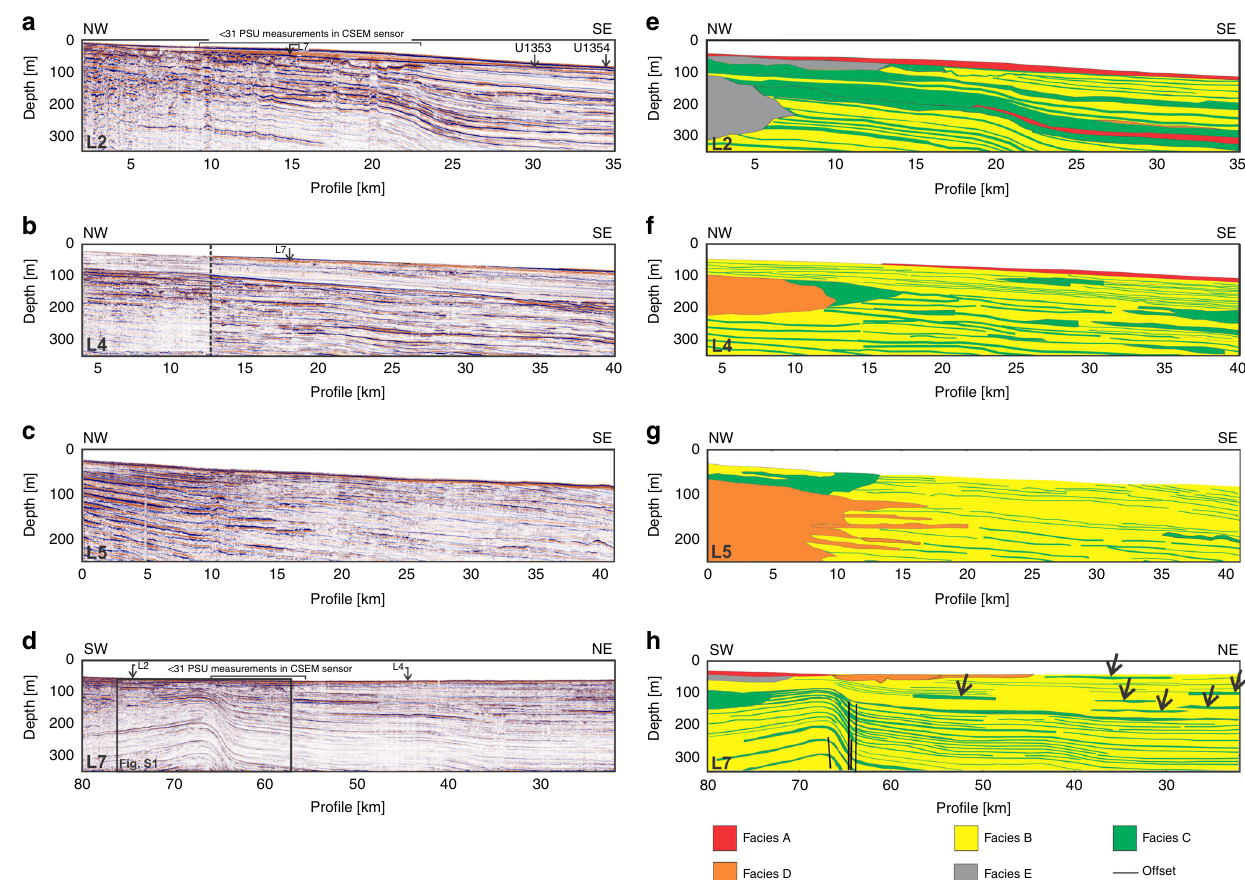
Fig. 3 Multichannel seismic re fl ection pro fi les. a – d Processed seismic re fl ection pro fi les along lines 2, 4, 5 and 7. Location in Fig. 1. Location of intersecting pro fi les, boreholes U1353 and U1354, and low water column salinity values (derived from the conductivity – temperature – depth sensor on the CSEM instrument) are shown. The dotted line in L4 marks the boundary between two seismic re fl ection pro fi les acquired using different acquisition equipment and geometry, and in different weather conditions. e – h Interpreted facies. Offsets in seismic re fl ectors in line 7 are marked by black lines. Black arrows denote interpreted buried valleys in fi lled by coarse-grained